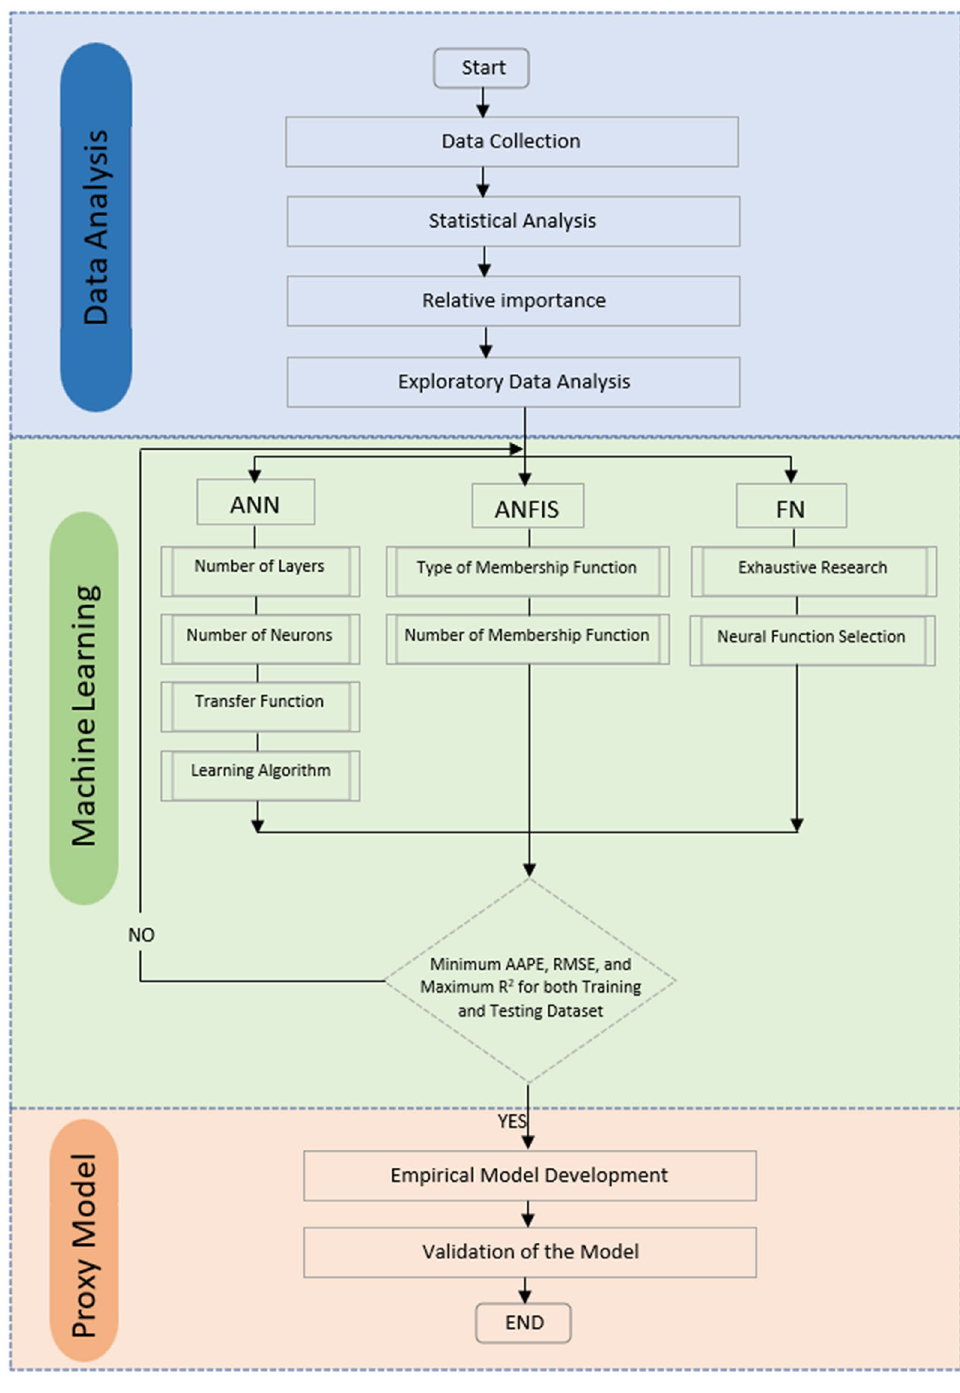
Figure 1. Workflow diagram demonstrating ML modelling